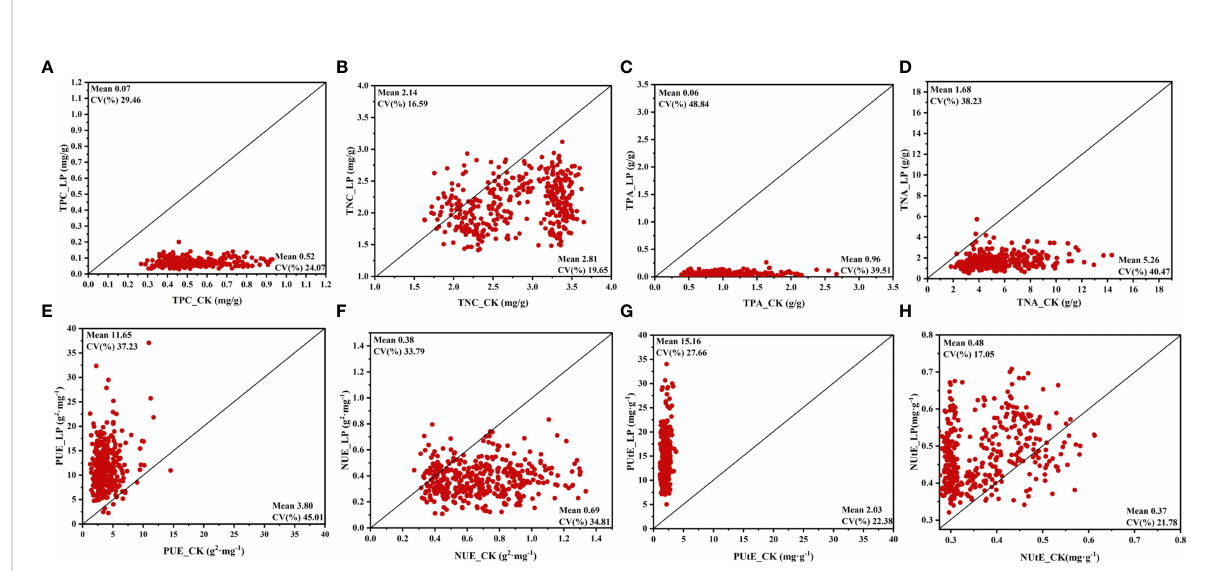
FIGURE 3 Variation in phosphorus and nitrogen ef fi ciency traits of 384 cotton plant accessions exposed to different P supplies for 28 days. (A) total phosphorus concentration (TPC), (B) total nitrogen concentration (TNC), (C) total phosphorus accumulation (TPA), (D) total nitrogen accumulation (TNA), (E) phosphorus use ef fi ciency (PUE), (F) nitrogen use ef fi ciency (NUE), (G) phosphorus uptake ef fi ciency (PUtE), (H) nitrogen uptake ef fi ciency (NUtE). The horizontal line in the picture is normal nutrition conditions (CK), and the vertical line is low phosphorus